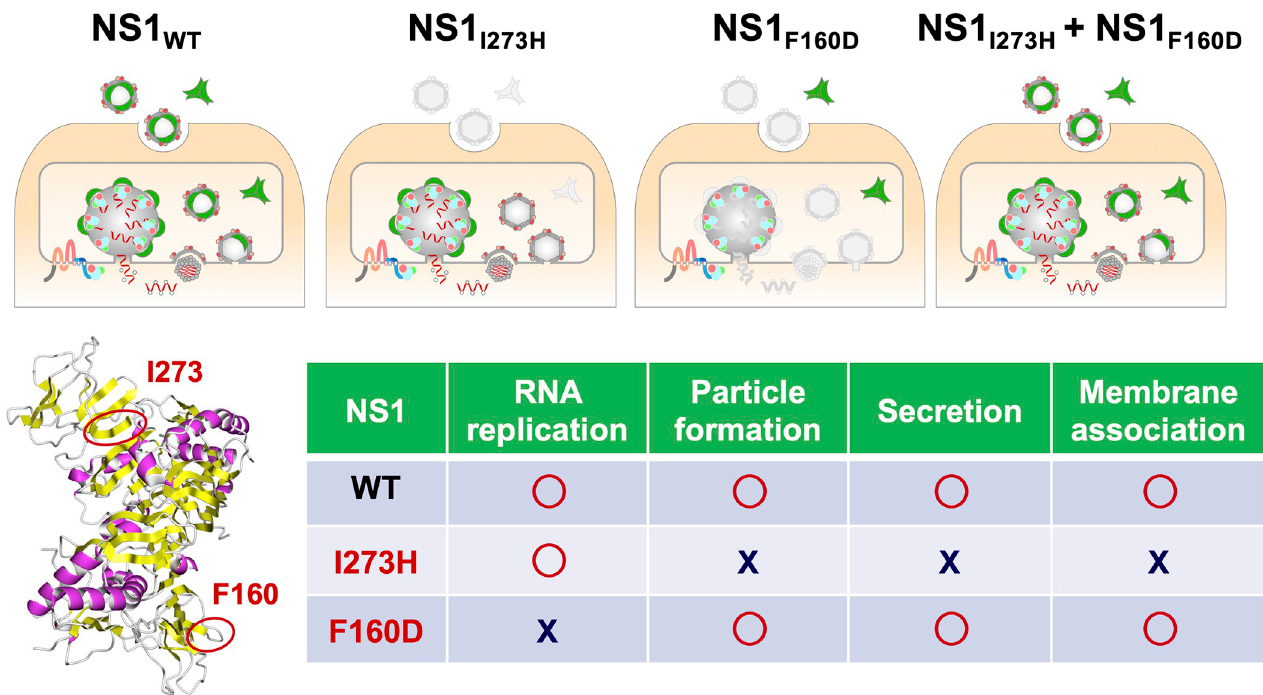
Fig 7. The secretory NS1 plays a crucial role in the infectious virus particle formation. The role of NS1 in viral RNA replication and the secretory machinery elucidated in this study are illustrated.